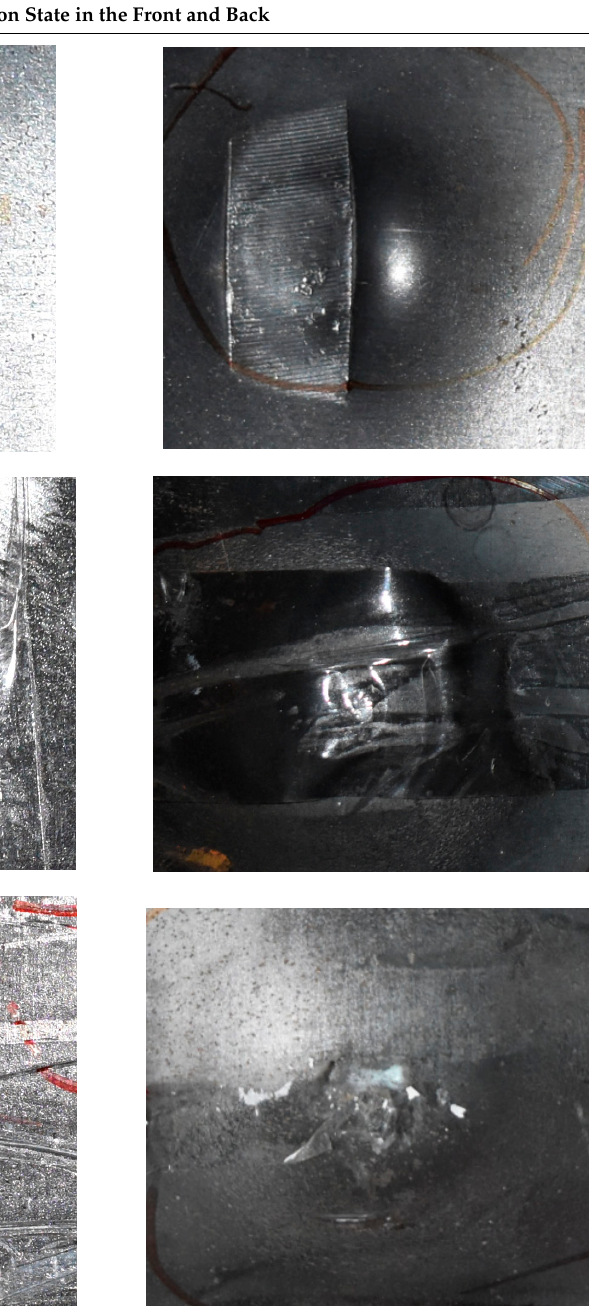
Table 9. Ballistic impact results of armor with two layers of PE.